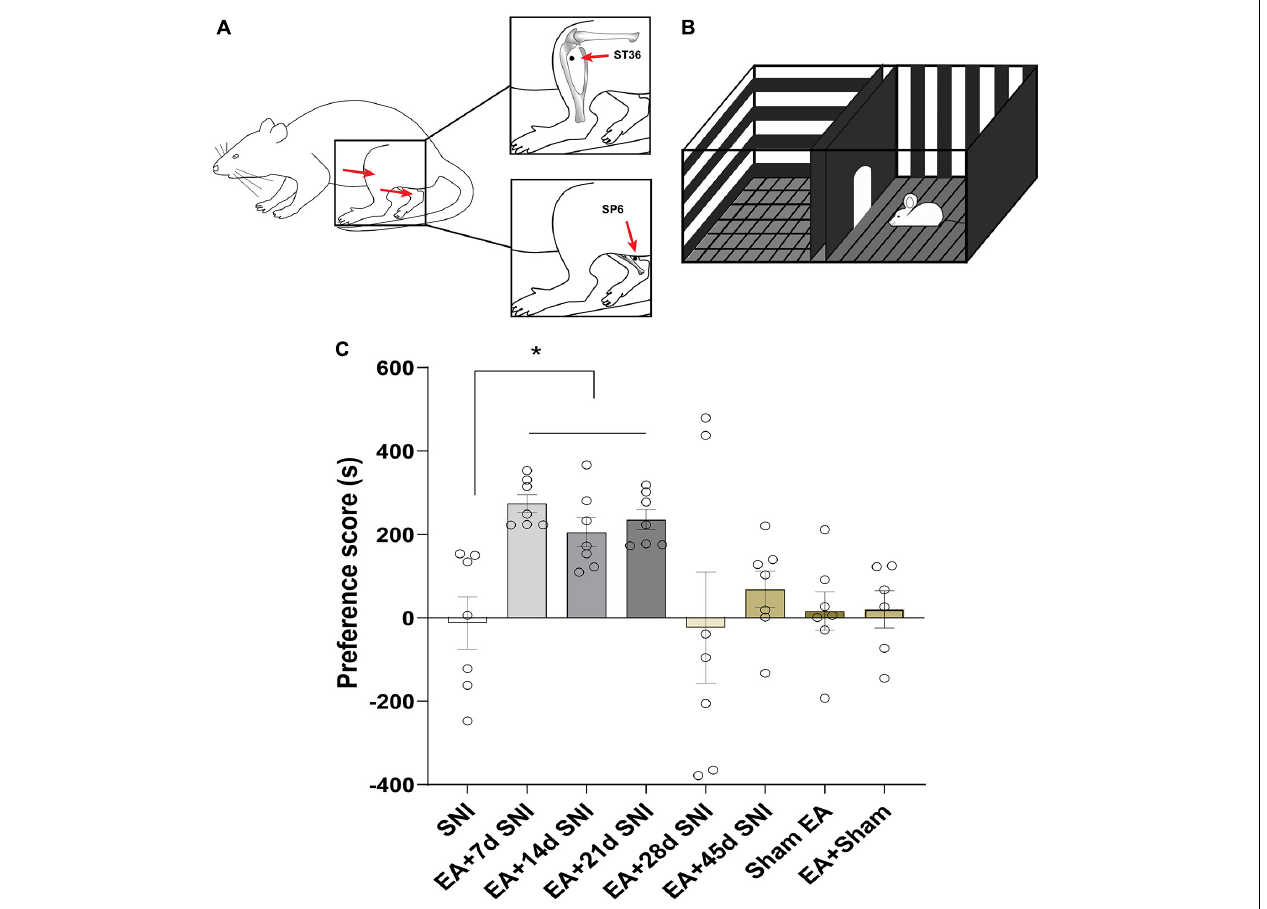
FIGURE 2 | Electroacupuncture induced CPP at the early phase of chronic pain but not at the late phase. (A) Placement of EA stimulation. EA was performed at the acupuncture points ST36 and SP6 (solid circle). (B) A standard two-chamber for CPP conditioning and test. (C) The preference scores among the various groups. * p < 0.01 vs. SNI